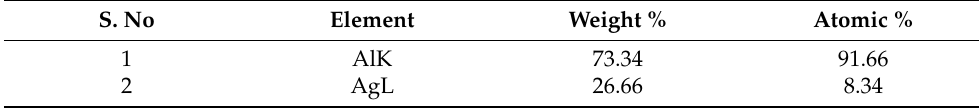
Figure 6. SEM–EDX measurement of different areas showing corresponding peaks (the red spot and the yellow arrows in ( a ) shows the peak on the surface while ( b ) shows the graphical representation of the nanoparticles). Table 3. Values of weight and atomic percent by SEM EDX.